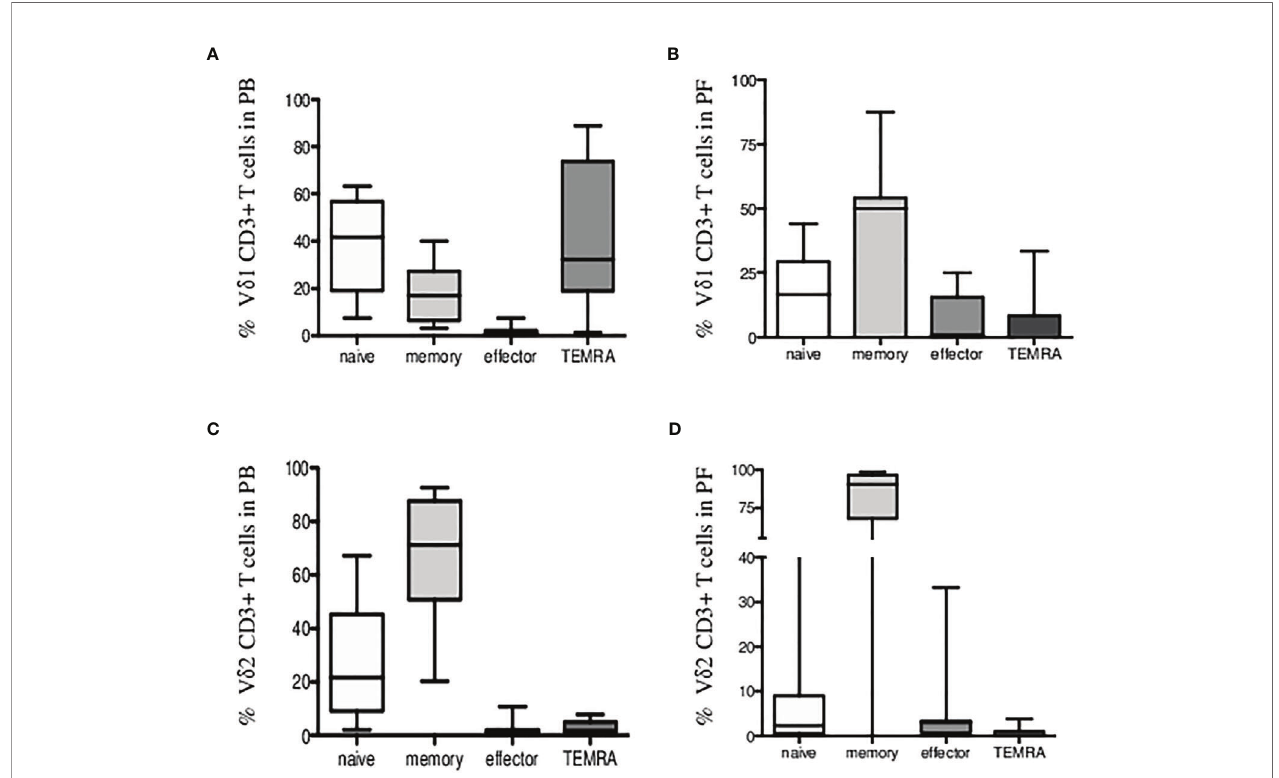
FIGURE 3 | Immunophenotyping of V d 1 and V d 2 gd T cells in endometriosis patients. Percentage of CD3+ V d 1 T cells (A) in peripheral blood and (B) in peritoneal fl uid samples showing expression of CD27 and CD45RA markers for naïve/memory/effector and TEMRA phenotypes. (C) Percentage of CD3+ V d 2 T cells in peripheral blood and (D) in peritoneal fl uid samples is